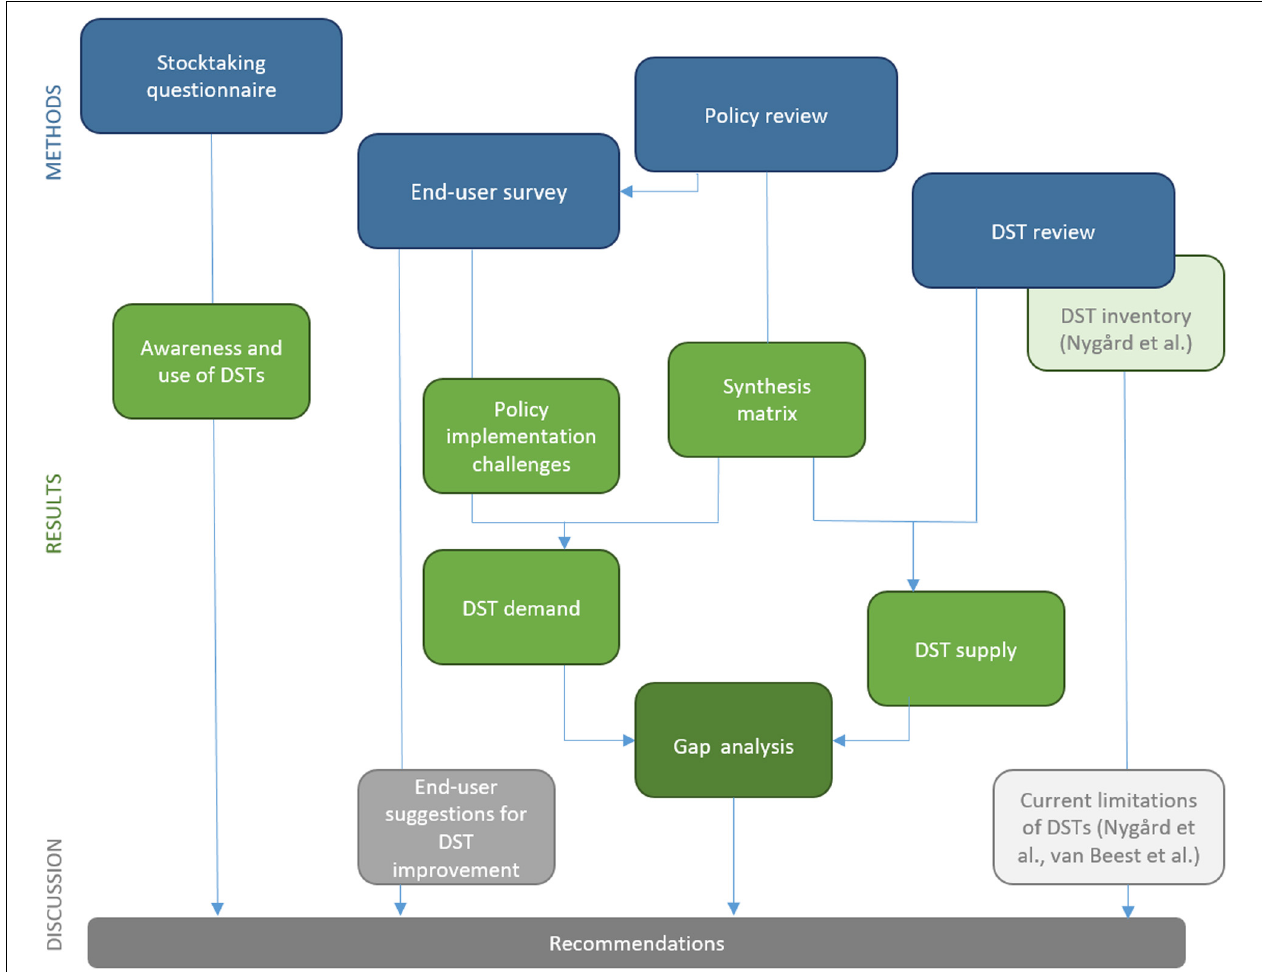
FIGURE 1 | The work flow diagram shows the main study methods, and results and how they feed into the recommendations according to their chronological occurrence in this study (from top to